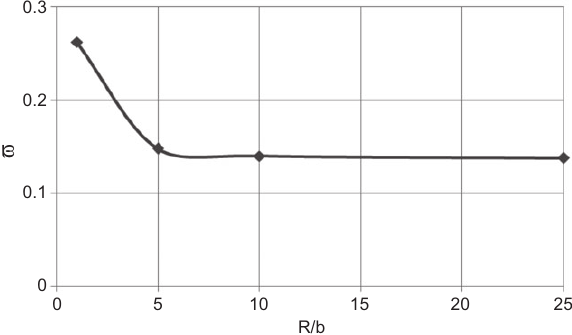
Figure 4 Effect of the curvature ratio on the fundamental for simply supported square laminated spherical shells.